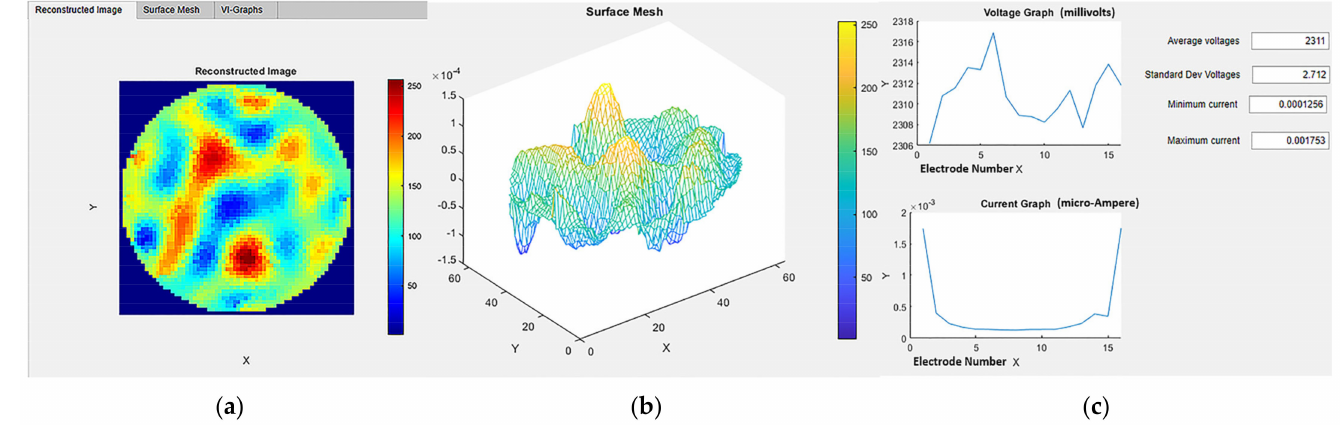
Figure 7. Reconstruction module: Panel for advanced visualization tabs ( a ) 2D reconstruction; ( b ) 3D surface mesh visualization; ( c ) graphical and numerical